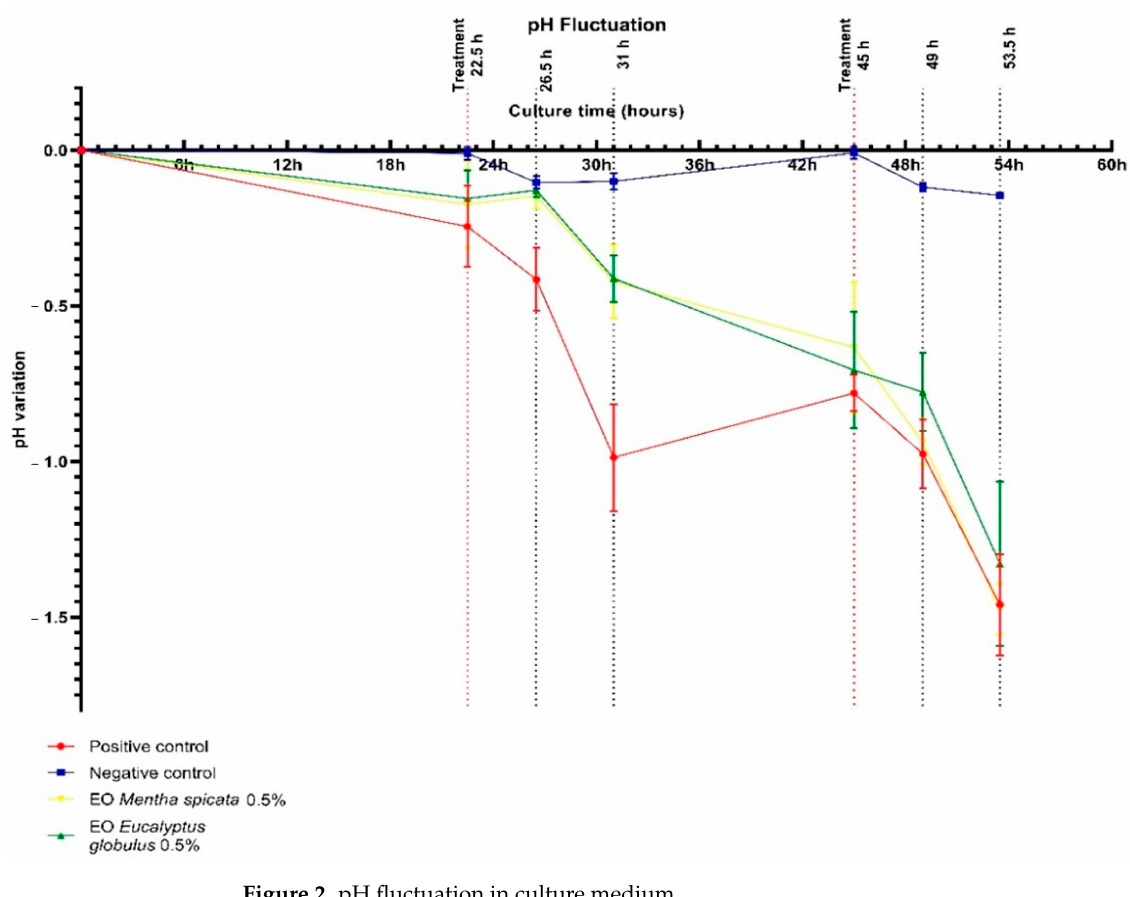
Figure 2. pH fluctuation in culture medium.